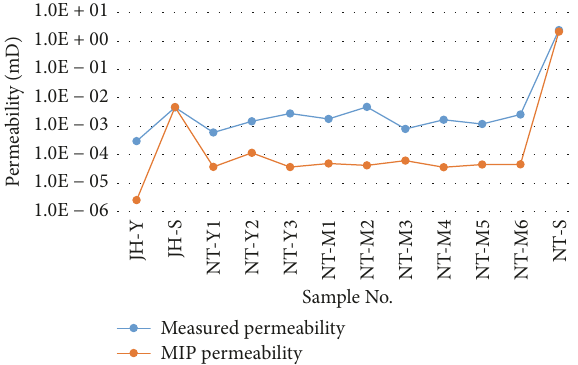
Figure 10: Comparison between the calculated MIP permeability ( 𝐾